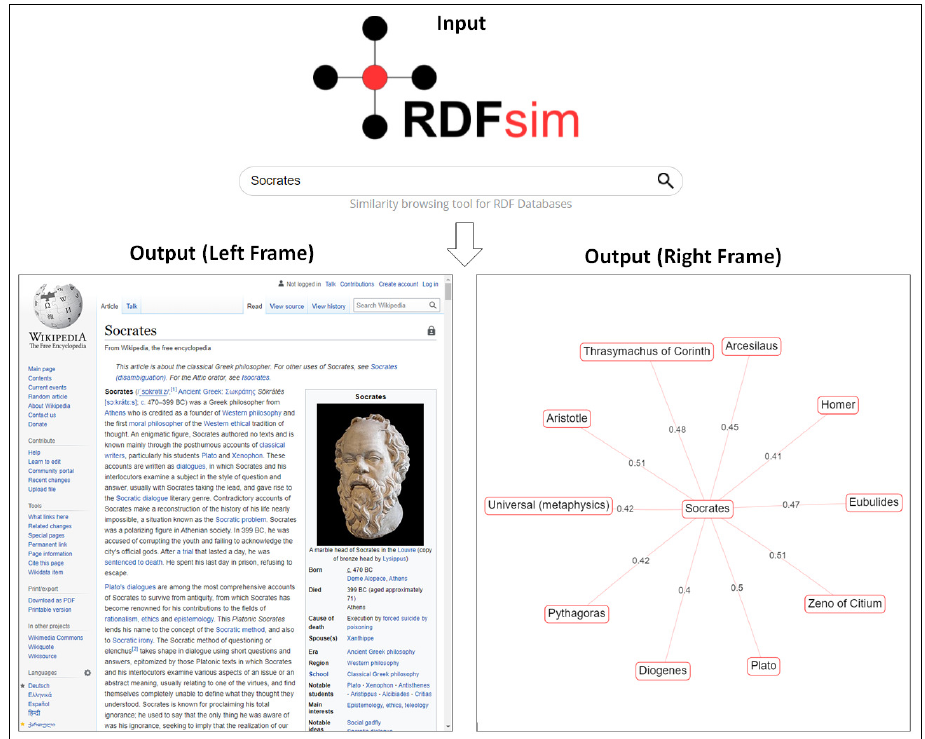
Figure 2. The default browsing system of RDFsim for the entity